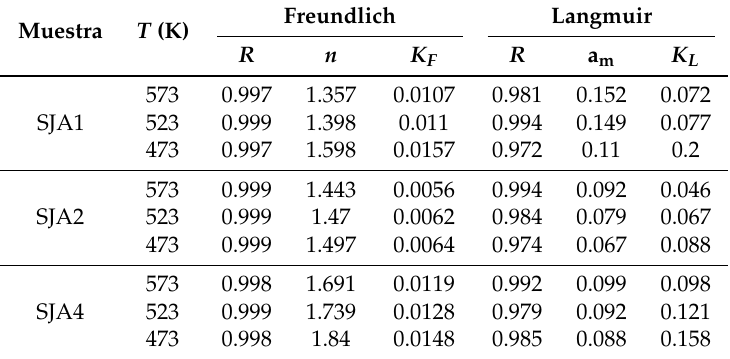
Table 3. Freundlich and Langmuir parameters for the adsorption of CO 2 in soils samples with correlation coefficients.